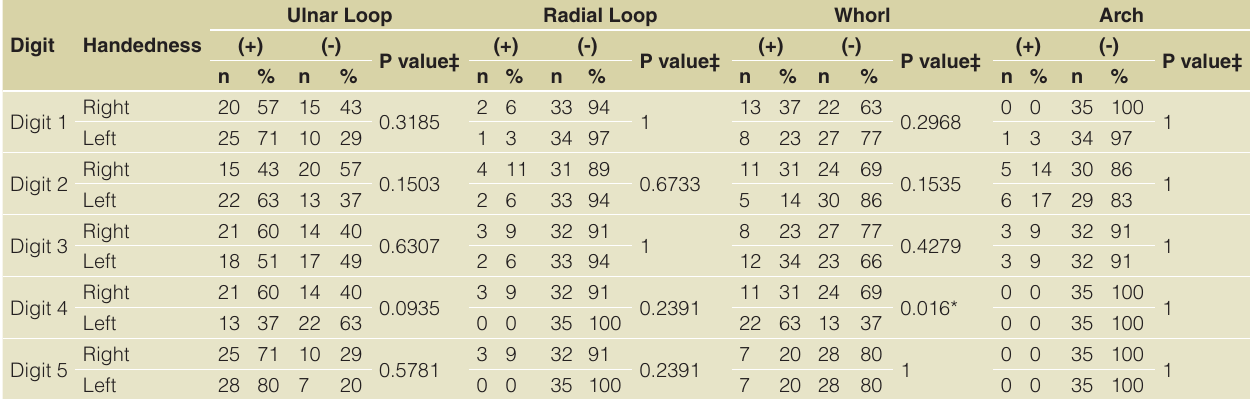
Table 4. Digital dermatoglyphic pattern distribution of left hand in males.